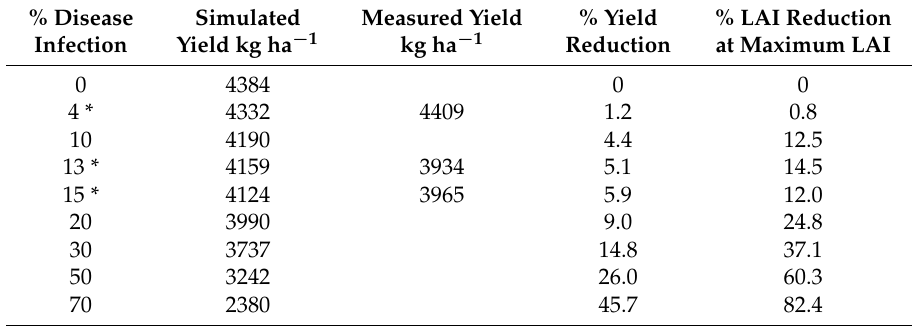
Table 4. Yield evaluation of the sensitivity analysis from the Ihinger Hof dataset, by comparing the percentage disease infection with STB and the corresponding simulated percentage yield reduction in kg DM ha − 1 for the cultivar